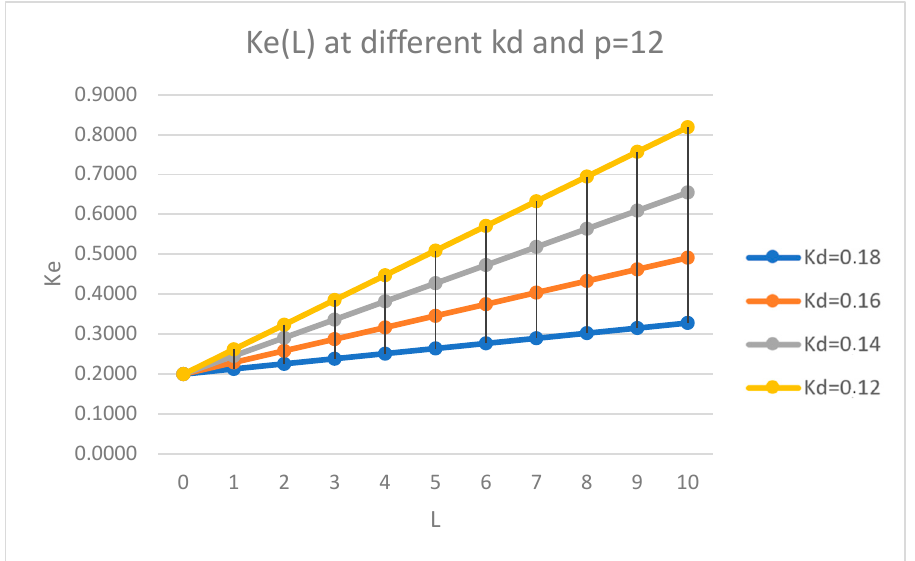
Figure 20. Dependence of the equity cost, k e , on leverage level L at different debt cost k d (12%; 14%; 16%; 18%) and fixed frequency of payments of tax on profit p = 12.